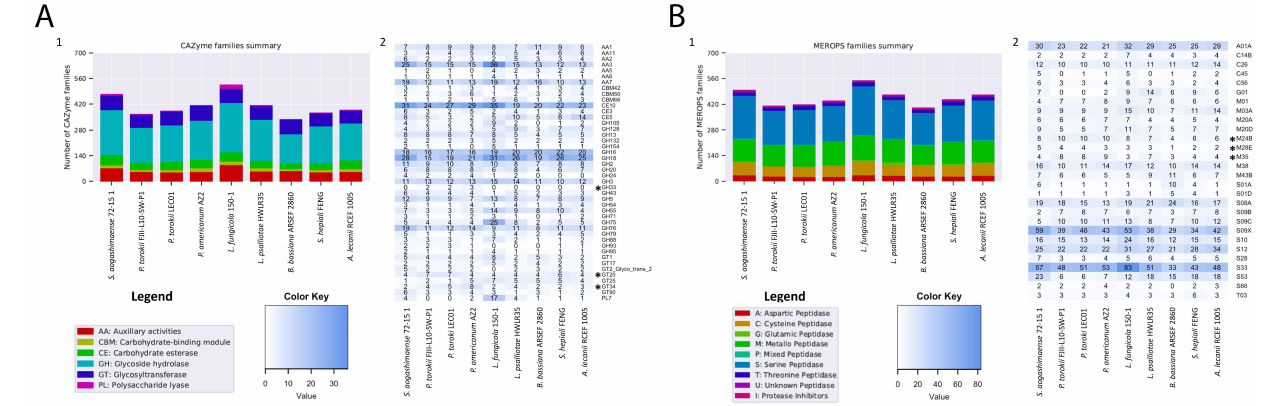
Figure 5. Comparative genomic analyses of Cordycipitaceae fungi. ( A ) Carbohydrate-active en- zymes (CAZymes) and ( B ) proteases (MEROPS). Each category with a standard deviation > 1 was plotted in the heat map. Asterisks represent the more prominent changes in Parengyodontium lineage in both CAZy and MEROPS classes. The numerical number “1” represents for the major families shown in bar plot and “2” depicts the significantly enriched or depleted functional